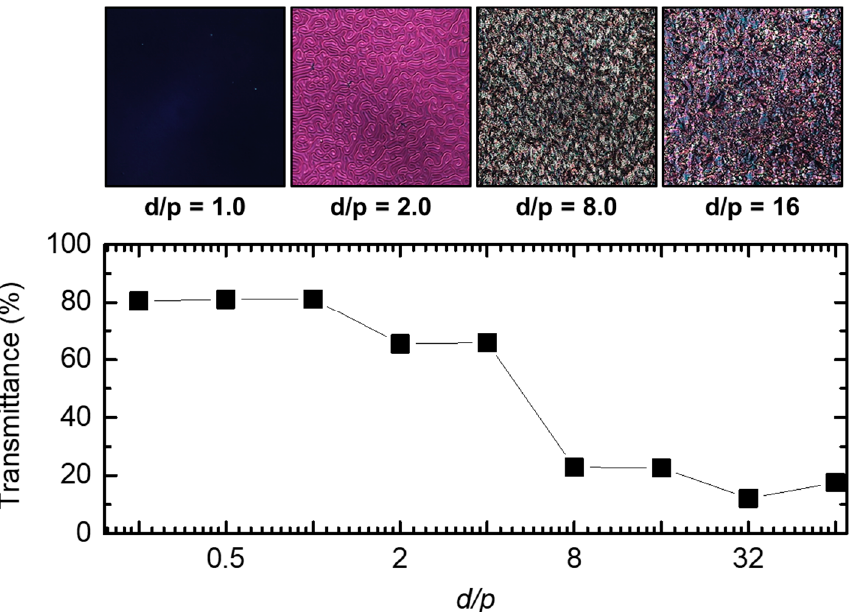
Figure 1. Transmittances and polarized optical microscope (POM) images of liquid crystal (LC) cells with homeotropic anchorings as functions of the d/p (the ratio of the cell gap and pitch length). LC cells were fabricated using an achiral nematic LC (E7) and a chiral dopant (S811) with a fixed cell gap of 10 μ m.